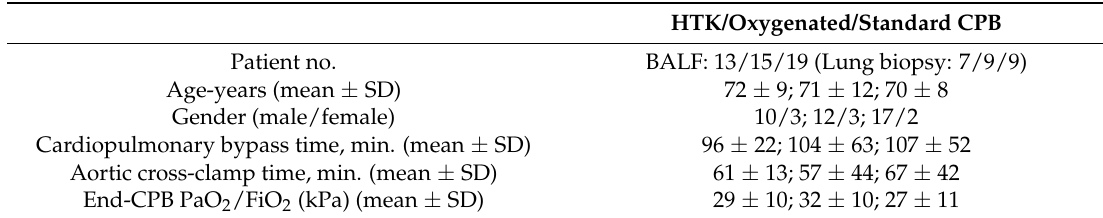
Table 1. Patient